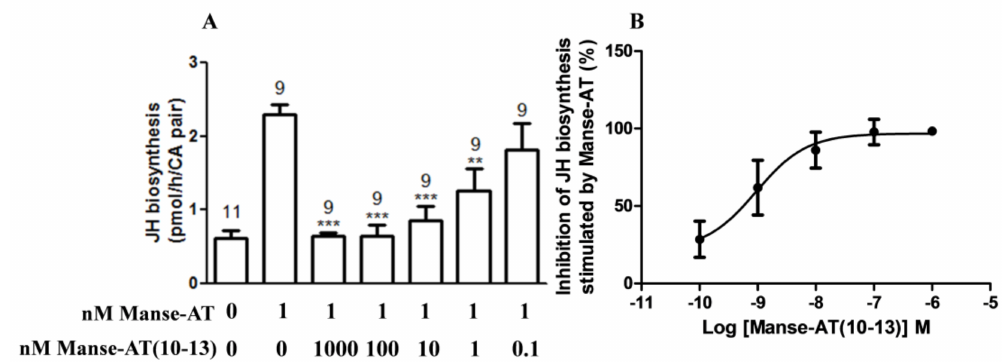
Figure 5. Antagonistic effects of Manse-AT (10–13) on JH biosynthesis. ( A ) Manse-AT (10–13) is a potent Manse-AT antagonist in the CA; ( B ) Dose response curves of Manse-AT (10–13) on the inhibition of JH stimulation of Manse-AT. Each bar represents the mean ± SEM for the number of individual measurements indicated error bars. Asterisks indicate significant differences between Manse-AT and mixture solutions as determined by Dunnett’s multiple comparison test following one-way ANOVA: ** 0.0001 < p < 0.05; *** p <